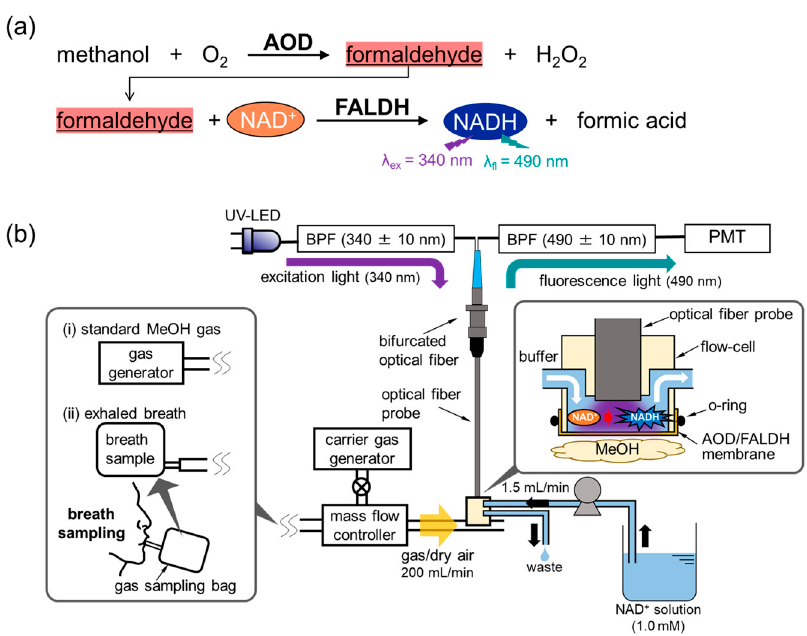
Figure 1. ( a ) Measurement principle, and ( b ) a schematic illustration of the MeOH